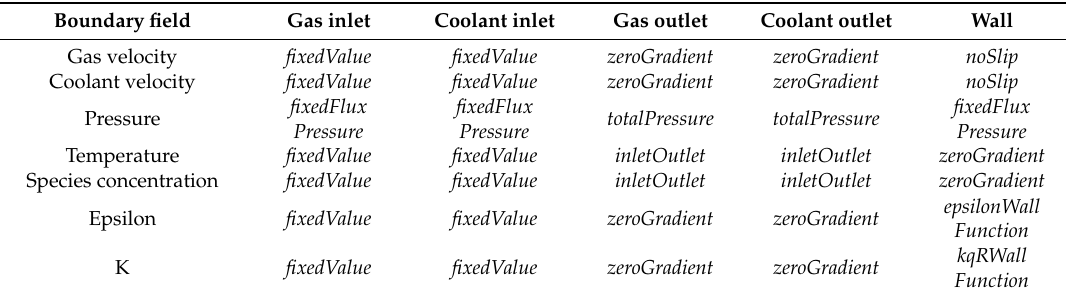
Table 4. Computational boundary conditions.